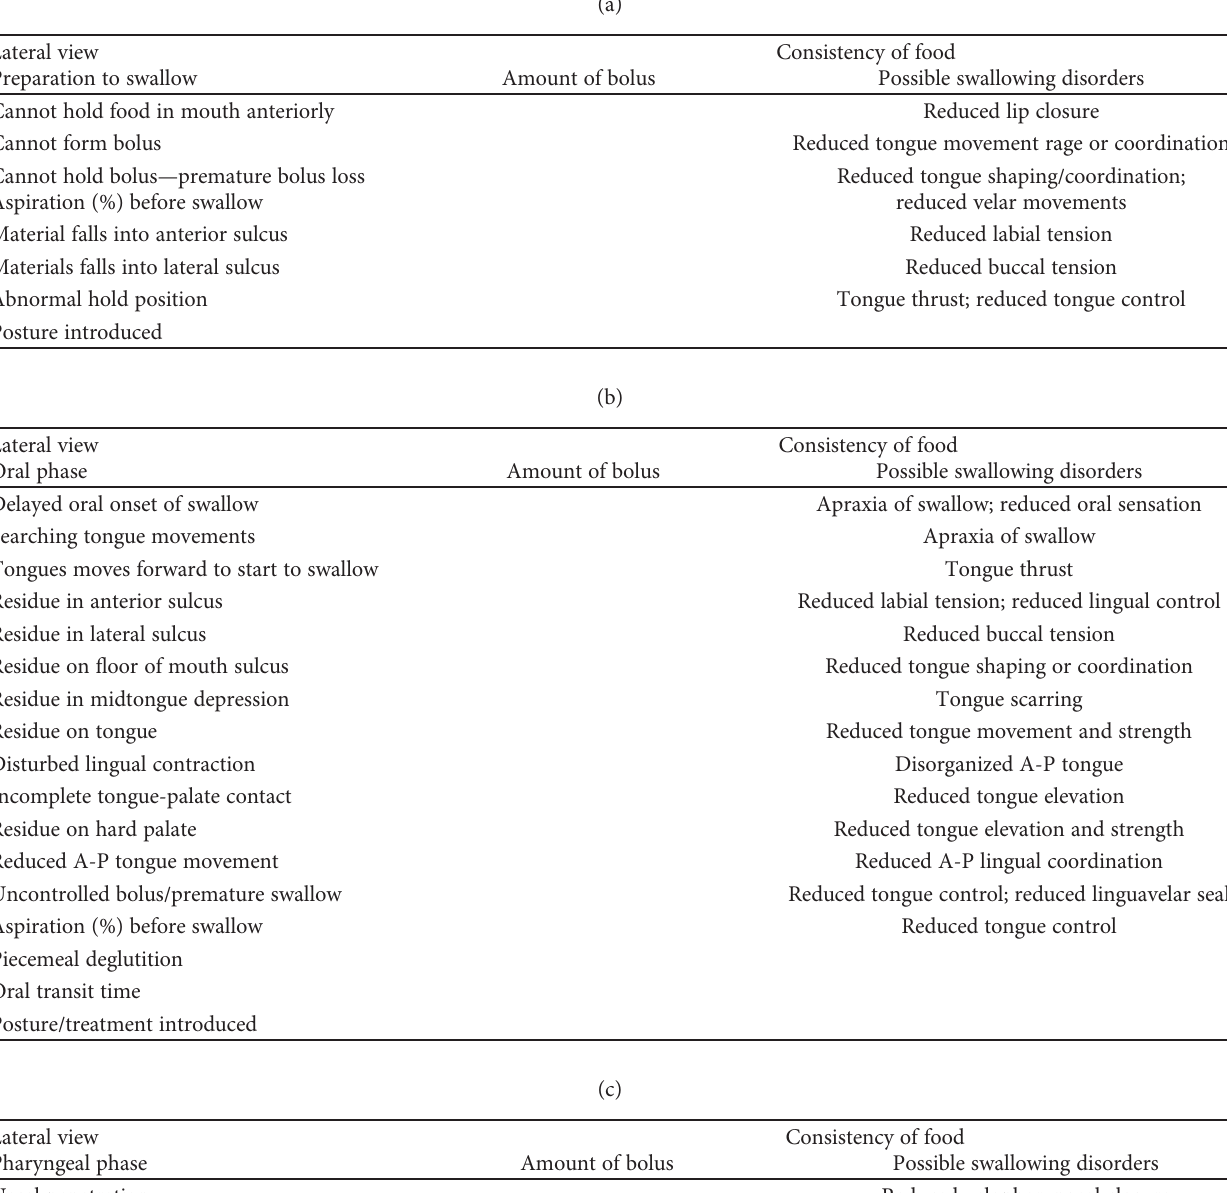
Table 2: (a) Logemann ’ s worksheet for preparation to swallow in lateral view. (b) Logemann ’ s worksheet for oral phase in lateral view. (c) Logemann ’ s worksheet for pharyngeal and esophageal phases in lateral view. (d) Logemann ’ s worksheet for pharyngeal phase in anteroposterior